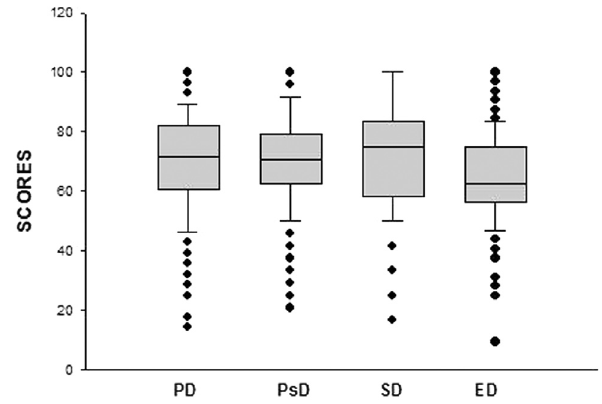
Figure 1 - Box plot showing the distribution of scores of quality of life in physical (PD), psychological (PsD), social (SD), and environment domains (ED). The central line represents the median, and the lower and upper limits represent the 25 th and 75 th percentiles, respectively. The vertical lines repre- sent the 10 th and 90 th percentiles, while the symbols indicate the extrapolated values that define these limits.